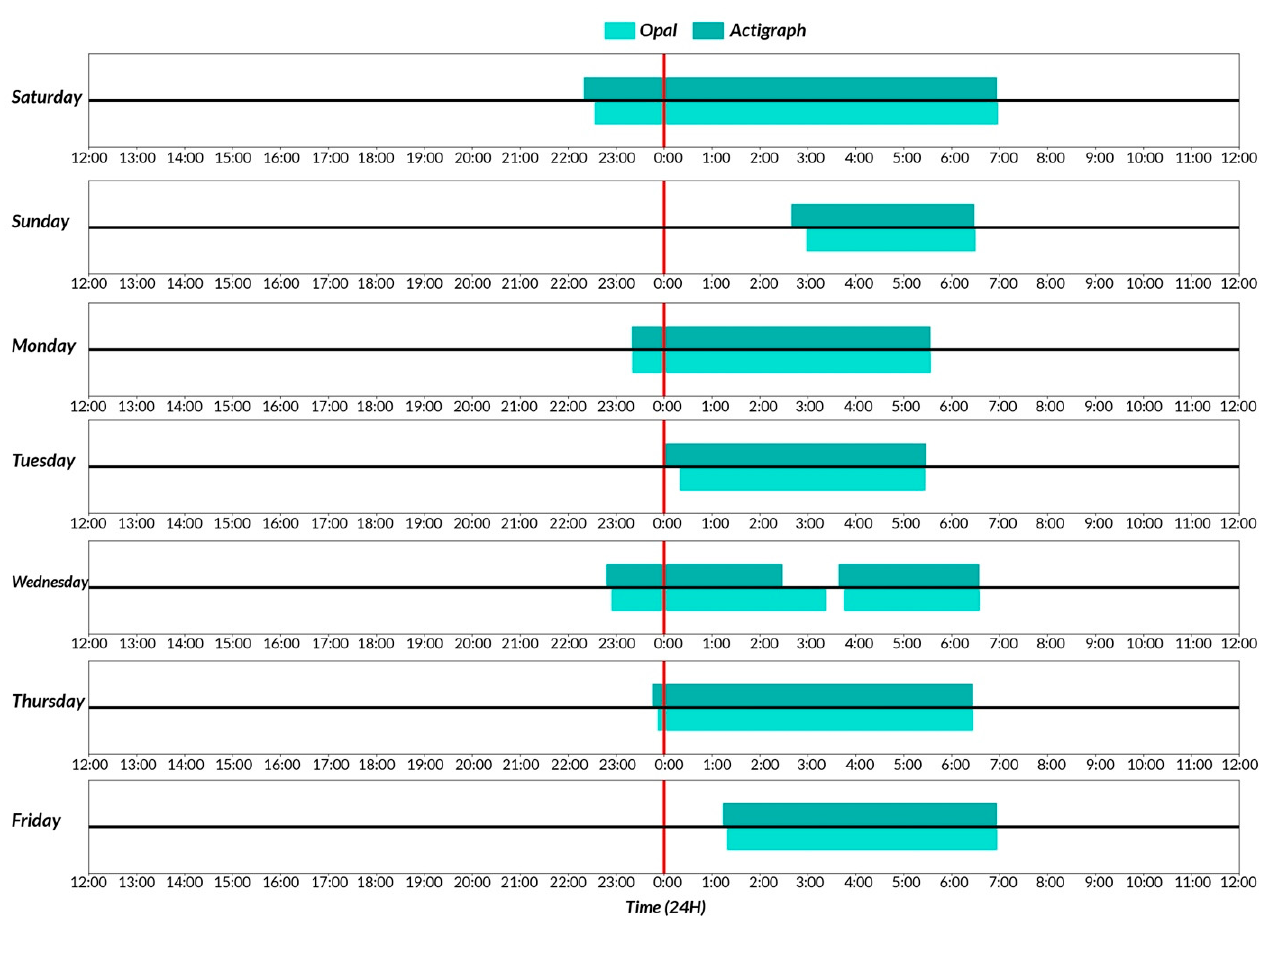
Figure 3. Sleep detection by Opal (light) versus Actigraph GT9X (dark) in a single participant over 7 days. Table 4. Performance of Opal versus Actigraph GT9X and Actigraph GT3X versus GT9X on sleep measures. Abbreviations: WASO = wake after sleep onset; AT = awakening time; AL = awakening length; SE = sleep efficiency.